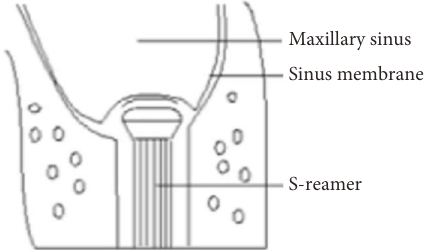
Figure 1: Schematic diagram of a bone